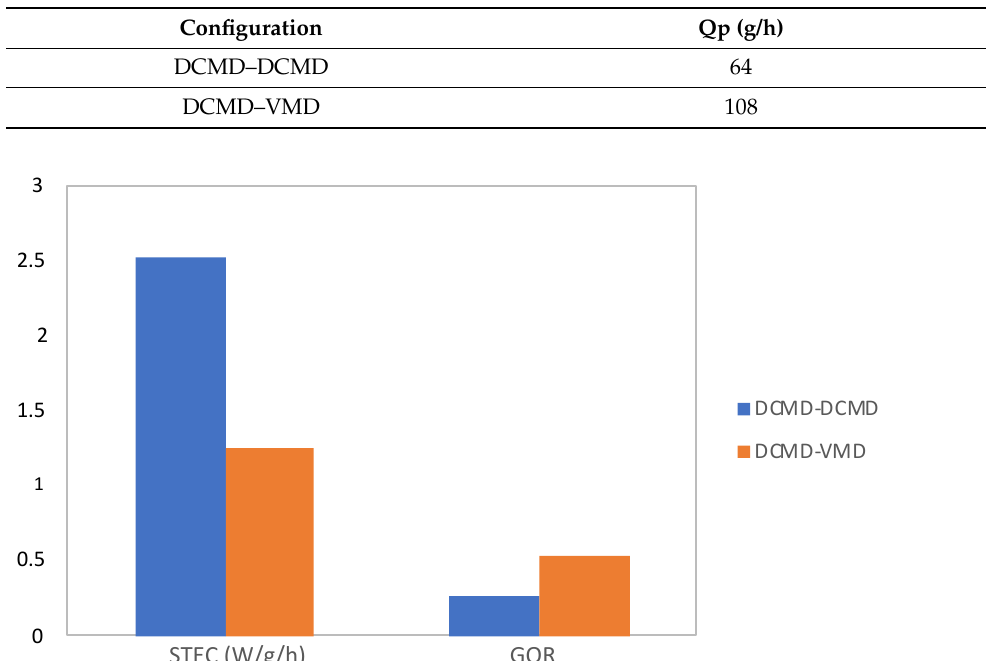
Table 4. Comparison between the flowsheet with the DCMD units in series and the integrated DCMD–VMD flowsheet in terms of permeate production.